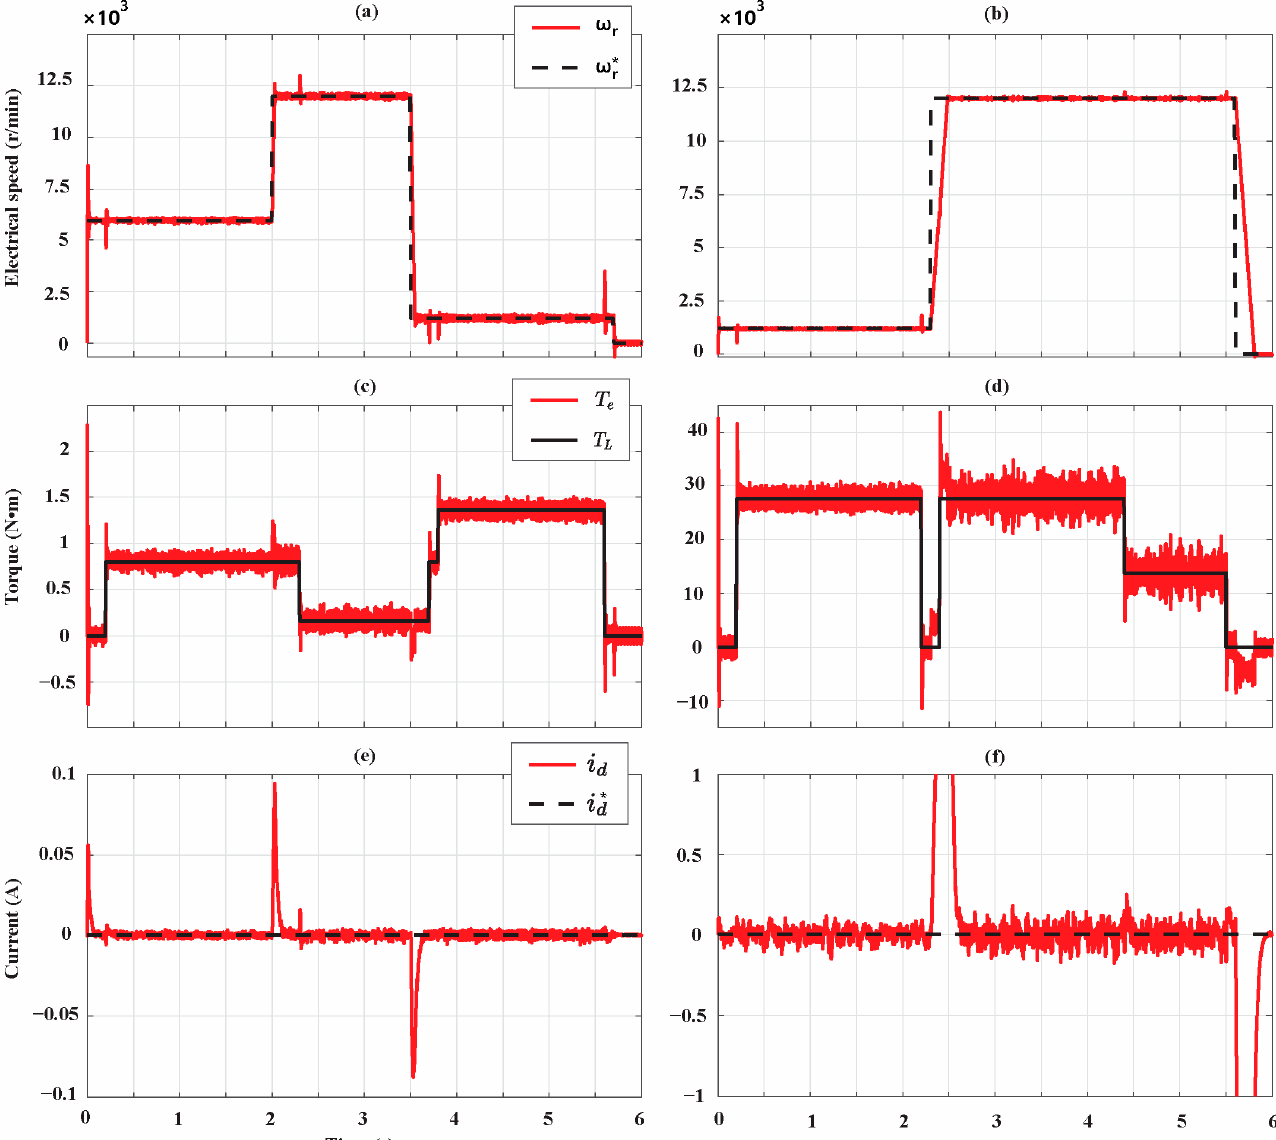
Figure 6. SPMSM working cycles: ( a , c , e ): speed, torque, and d-axis current profile of the Bonfiglioli 65; ( b , d , f ): speed, torque, and d-axis current of the Bonfiglioli 170.